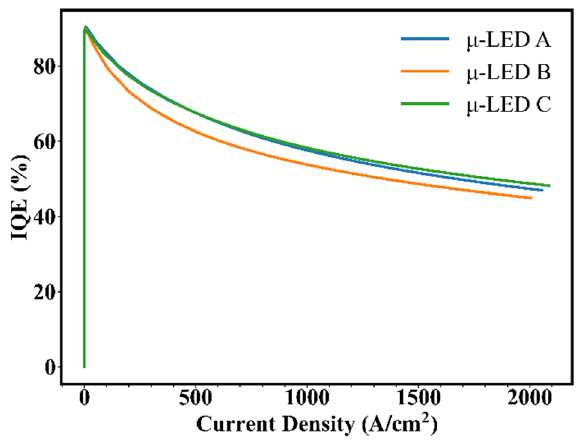
Figure 7. IQE vs. current density for μ -LED A, μ -LED B, and μ -LED C.